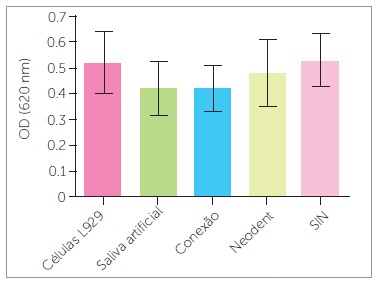
Crystal violet colorimetric assay for L929 cell samples incubated with extract solutions of mini-implants obtained after 30 days of immersion in artificial saliva.